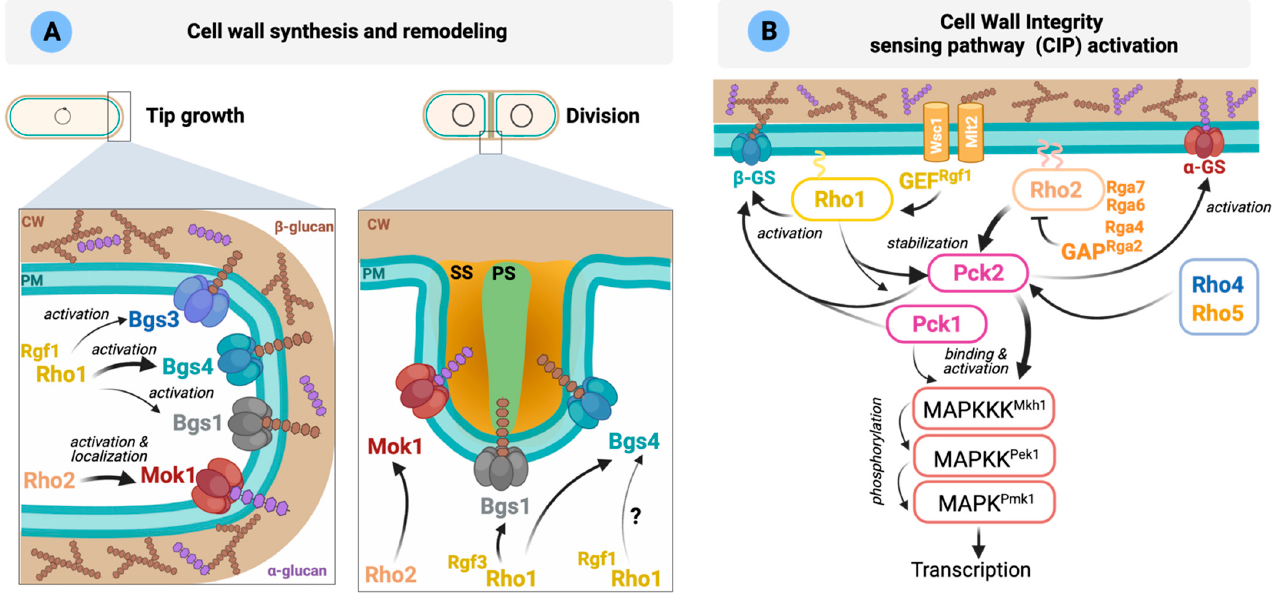
Figure 3. Rho GTPases involved in the regulation of CW integrity (adapted from [5,200]). ( A ) Cell wall synthesis at the cell tips during interphase is mediated by α -GS Mok1 ( α -glucan) and β -GS Bgs4 (branched β -1,3-glucan). Other β -GS (Bgs1 and 3) also localize to the poles where their role is less well understood. The main function of Bgs1 is the synthesis of the linear β -1,3-glucan of the primary septum, whereas Bgs4 (branched β -1,3-glucan) and Mok1 ( α -glucan) synthesize the polymers that form the secondary septum. The Rho GTPases involved in the activation of each GS are indicated in the figure. PM: plasma membrane; CW: cell wall; Glucose units ( , ); PS: primary septum; SS: secondary septum. ( B ) Sche- matic representation of S. pombe CIP activation. Wsc1 and Mtl2 activate Rho1 through the GEF Rgf1. Rho1 activates the β - GS and stabilizes Pck1 and Pck2. After activation by the phospholipid-dependent kinase Ksg1, both kinases activate the GS. Rho2 regulates Mok1 via Pck2. Rho2-Pck2 are the main activators of the CIP. Please see main text for more details. Both sensors physically couple the cell wall with the plasma membrane to activate Rho1 by two different networks [198]. One involves signaling from Mtl2 through Rho1 to Pck1, while the second one implicates specific signaling from Wsc1 and Rgf2 (and proba- bly also Rgf1) through Rho1 to activate GS and cell wall biosynthesis (Figure 3B). How- ever, Wsc1 and Mlt2 may act independently of the CIP, since CIP signaling is not compro- mised in mtl2 Δ and wsc1 Δ disruptants exposed to cell wall stress, suggesting that the func- tional relevance of S. pombe sensor-like proteins in the CIP pathway differs from that of S. cerevisiae [198]. In the latter, the cell surface sensors Wsc1-3, Mid2 and Mtl1 transmit cell wall stress to Rho1 through a set of GEFs and are responsible for activation of the Cell Wall Integrity MAPK pathway [201]. Cell wall homeostasis is regulated by the CIP, which is conserved in all fungi and shows a high degree of similarity to mammalian MAPKs of the ERK1/2 and ERK5 types (Figure 3B) (reviewed in [5,202]). As discussed above, in S. pombe , GTP-bound Rho1 and Rho2 interact with and stabilize the two redundant fission yeast PKC orthologs Pck1 and Pck2 [18]. Phosphoinositide-dependent kinase (PDK) ortholog Ksg1 mediates the in vivo